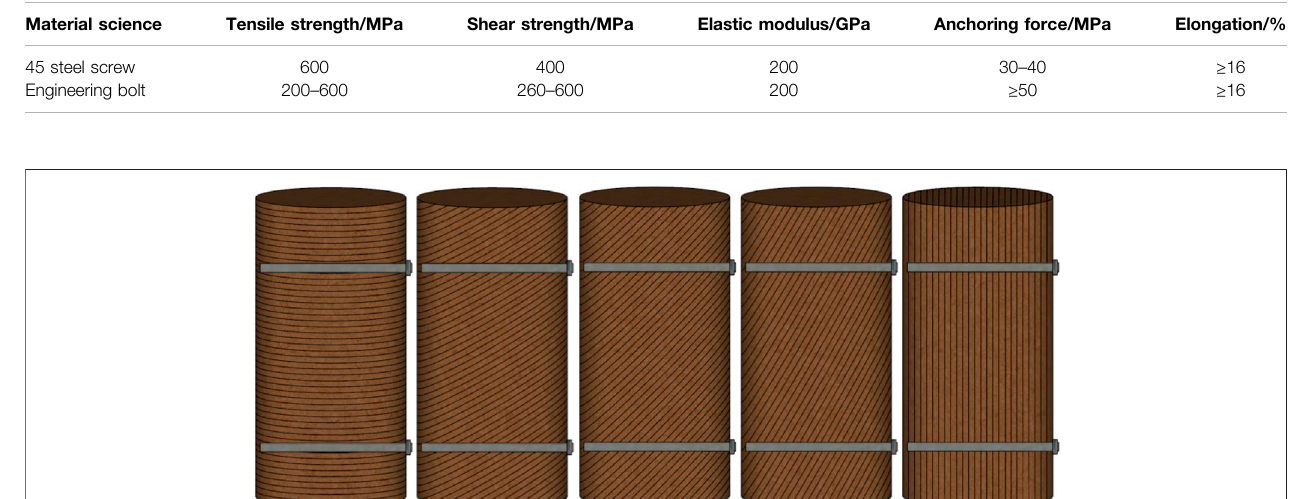
FIGURE 3 | Schematic diagram of anchor rock sample and anchor bolt